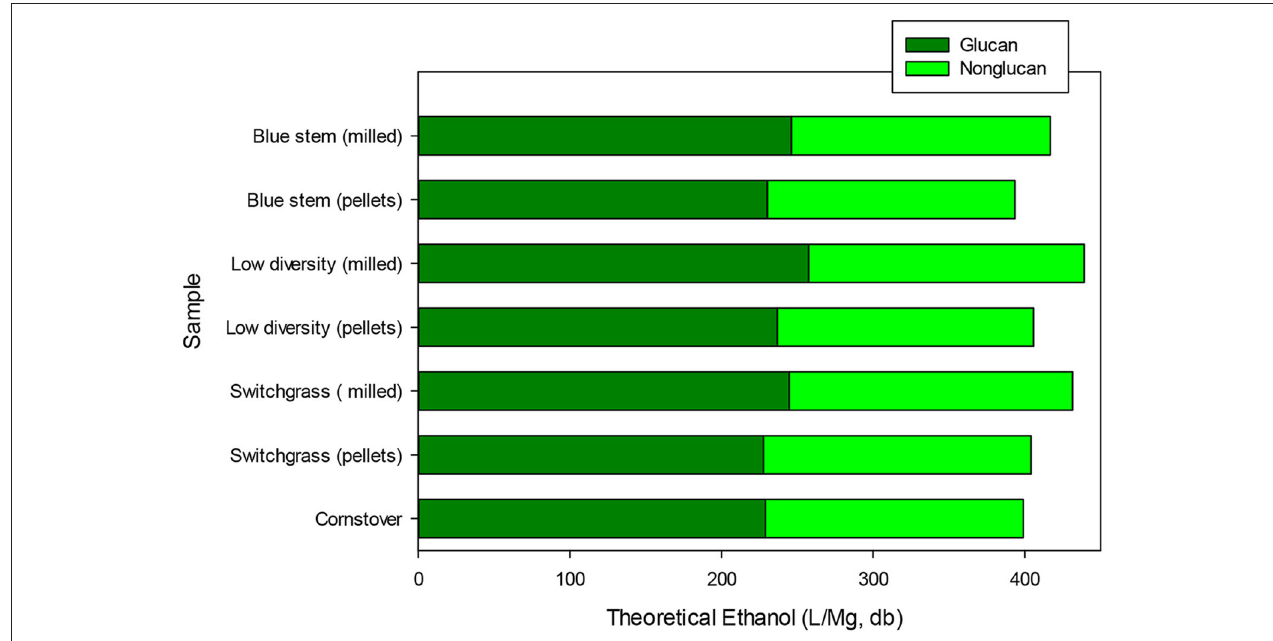
FIGURE 3 | Calculated maximum ethanol yields for pelletized and non-pelletized grass samples and comparison to expected yield from corn stover. Ethanol yields were calculated based upon carbohydrate contents assuming 100% recovery of neutral sugars using previously reported methods (Dien, 2010). Corn stover carbohydrate composition is based upon results from a large sampling study (Humbird et al.,